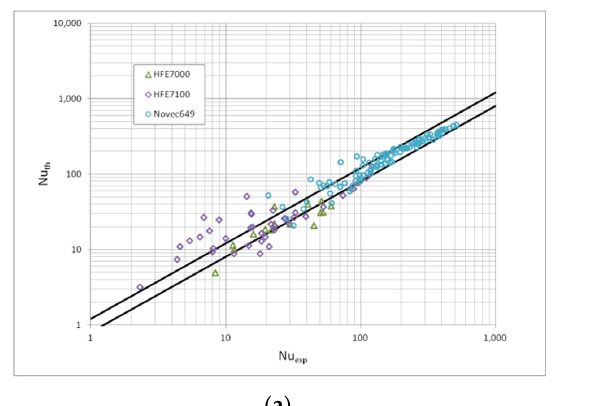
Figure 10. Comparison of the experimental investigation results of the HFE7000, HFE7100 and Novec649 refrigerants condensation in mini-channels which calculation results according to the correlation (1) for the dispersive structure; ( a ) for individual refrigerants, ( b ) for individual mini-channel diameters.